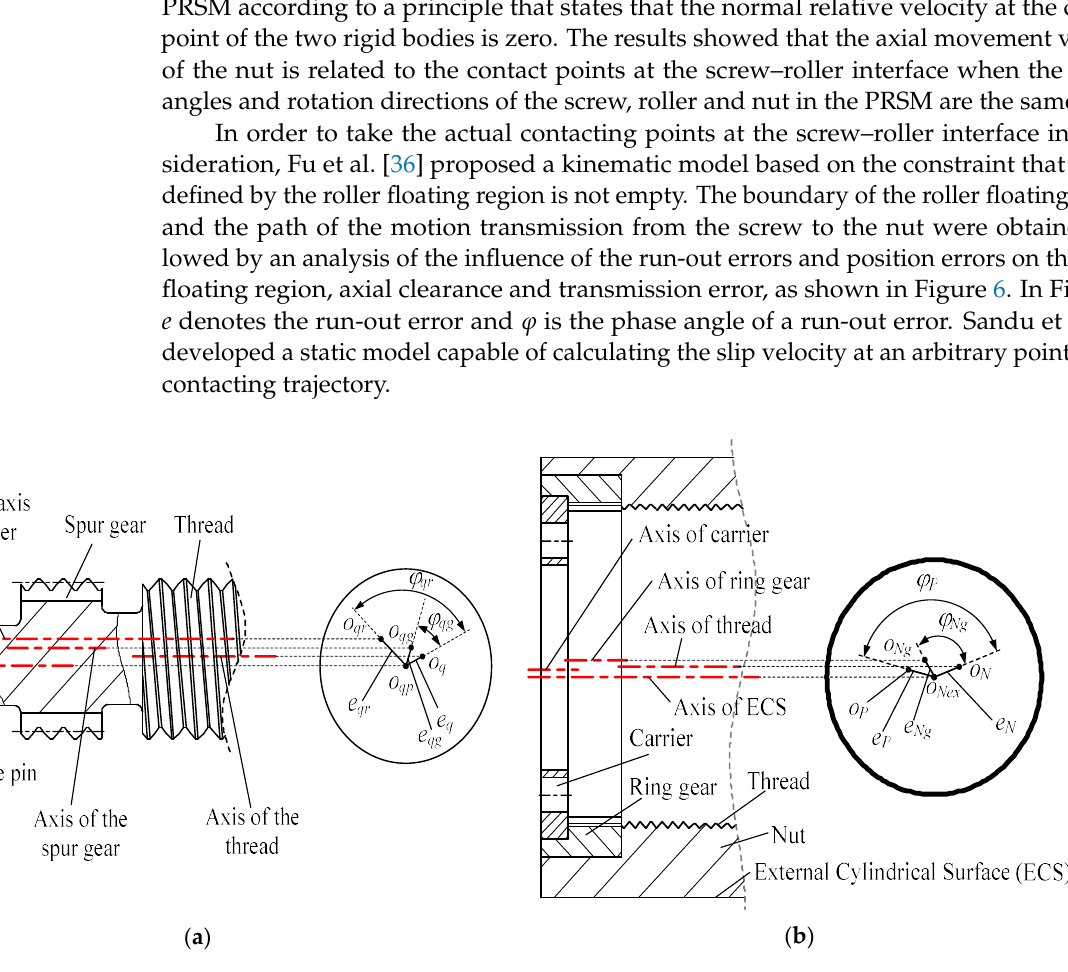
Figure 6. ( a ) Run-out errors of the roller; ( b ) run-out errors of the nut, ring gear and carrier in Ref. [36].